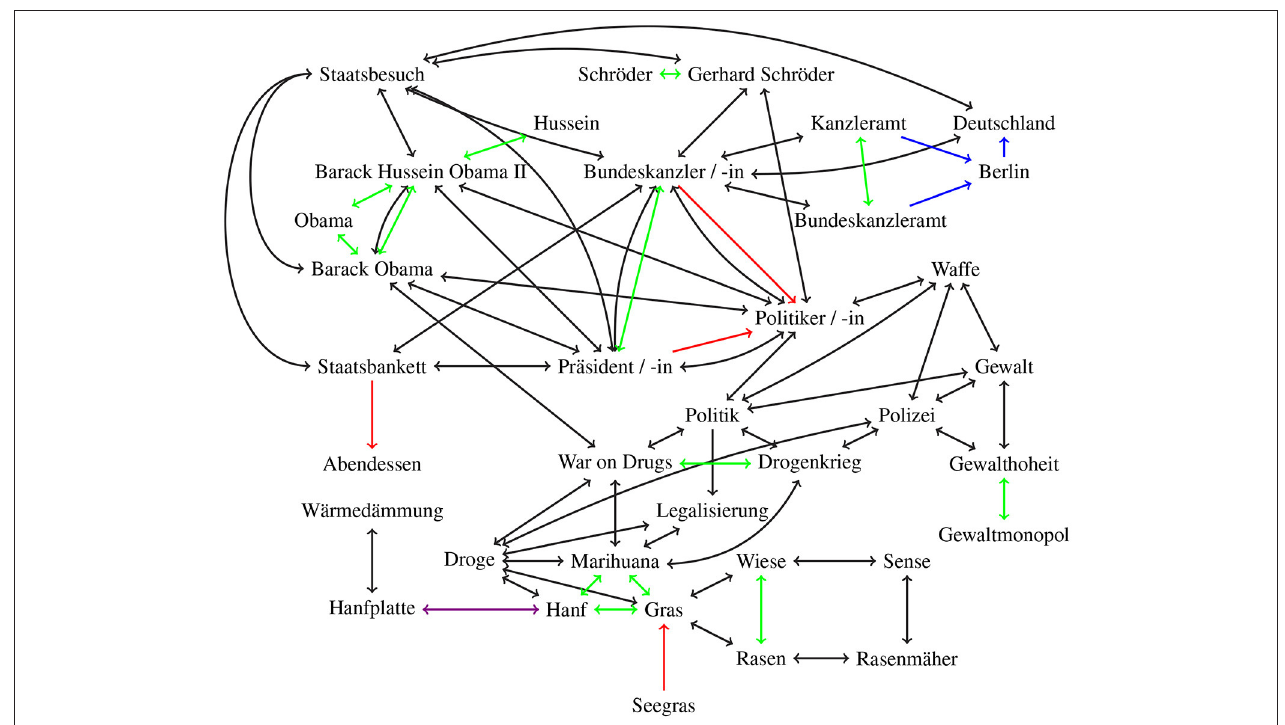
FIGURE 2 | Approximated word graph for our example text. Green arrows represent synonym-relations, red arrows hypernym relations, blue arrows location-based-relation, violet arrows meronym/holonym relations, and black arrows co-occurrences relations. Translations are listed in Table 1